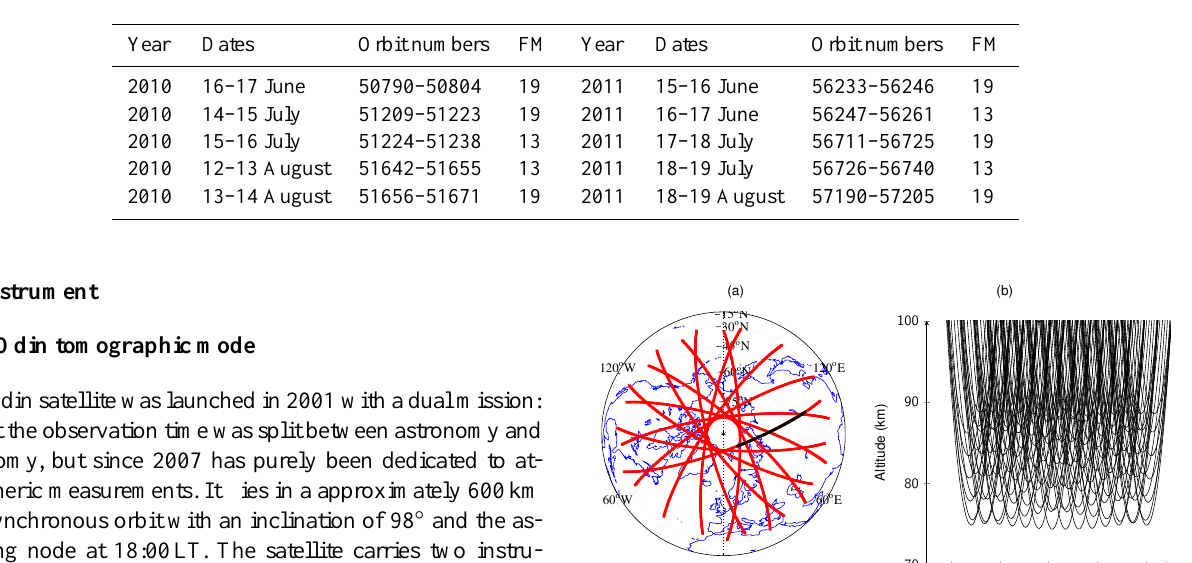
Table 1. Overview of Odin orbits, dates and frequency modes (FM) where tomographic modes are performed.